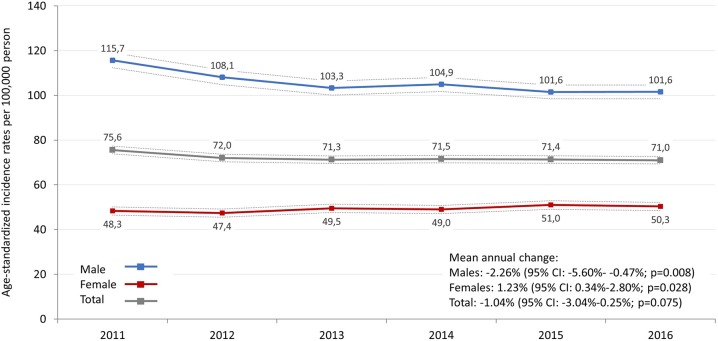
Age-standardized incidence rates (standard: ESP 2013) of lung cancer by sex in Hungary between 2011 and 2016 (per 100,000 person-years; dotted lines represent 95% CI). CI, confidence interval.